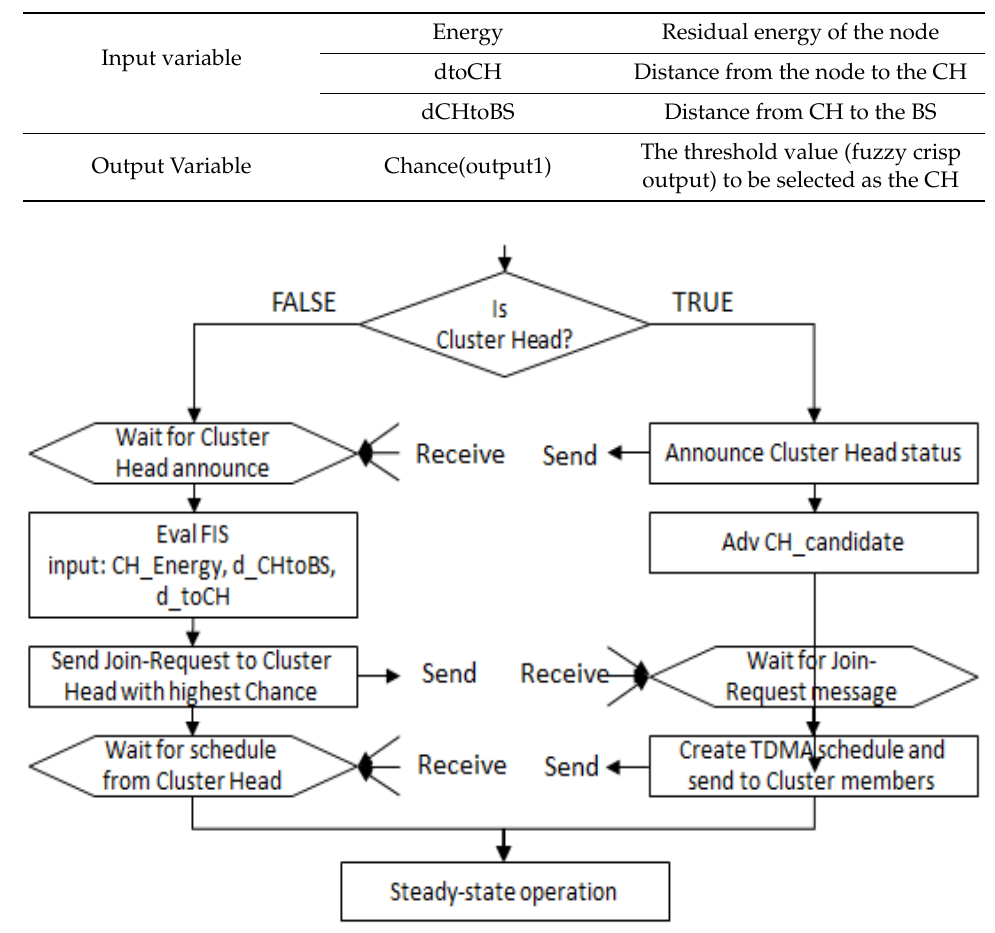
Figure 10. Flowchart of cluster configuration